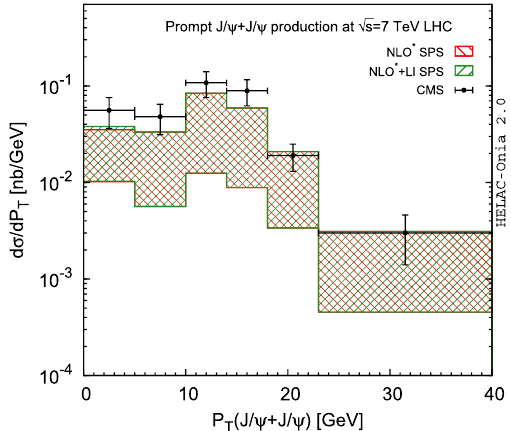
Fig. 11 P T ( J /ψ + J /ψ) distribution for CS SPS in the CMS accep- √ s = 7 TeV tance at